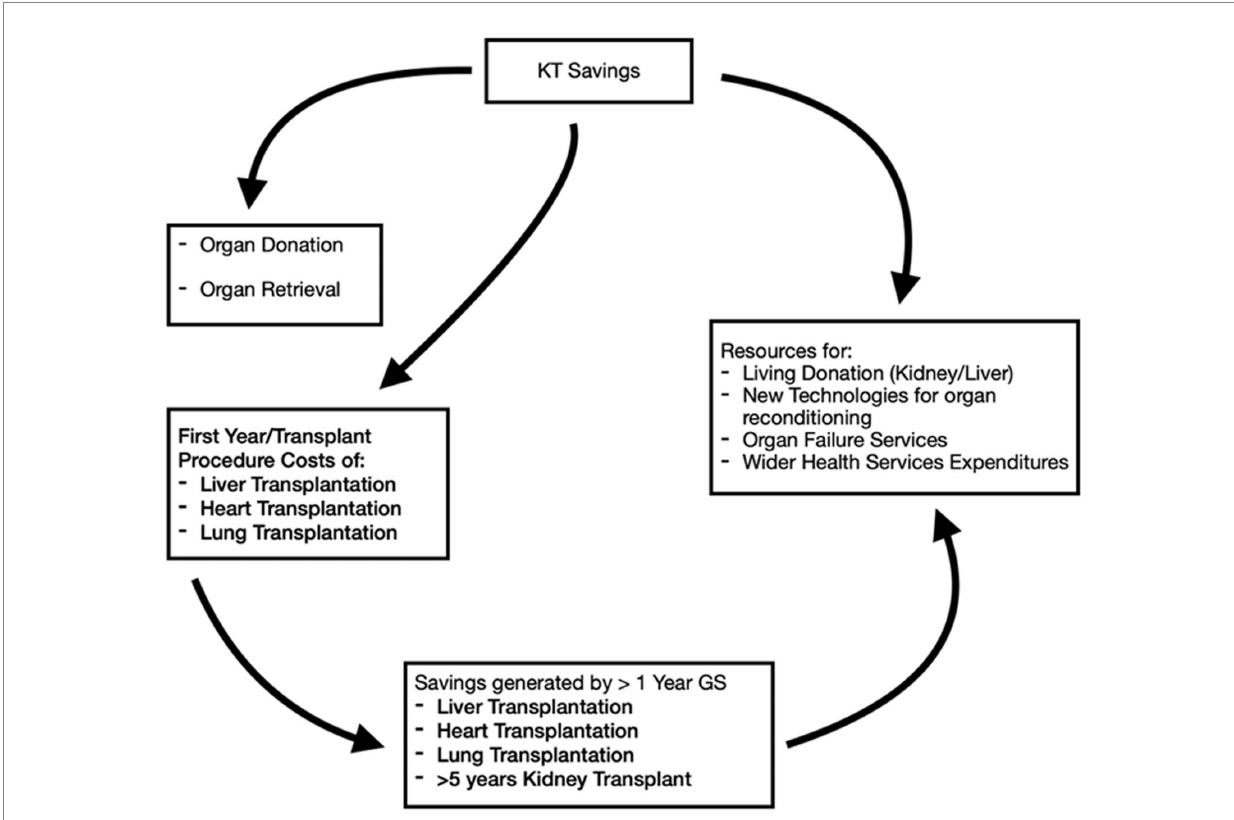
FIGURE 1 Potential flow of resources originating from the implementation of kidney transplant (KT)